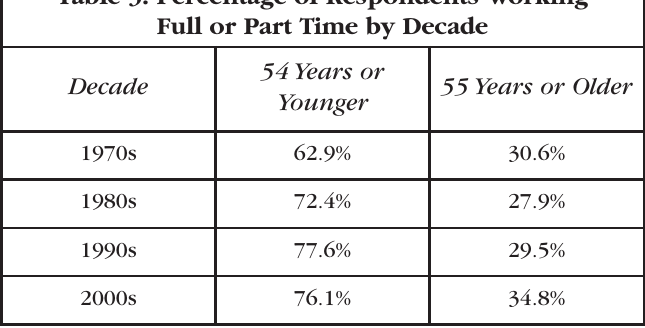
Table 3. Percentage of Respondents Working